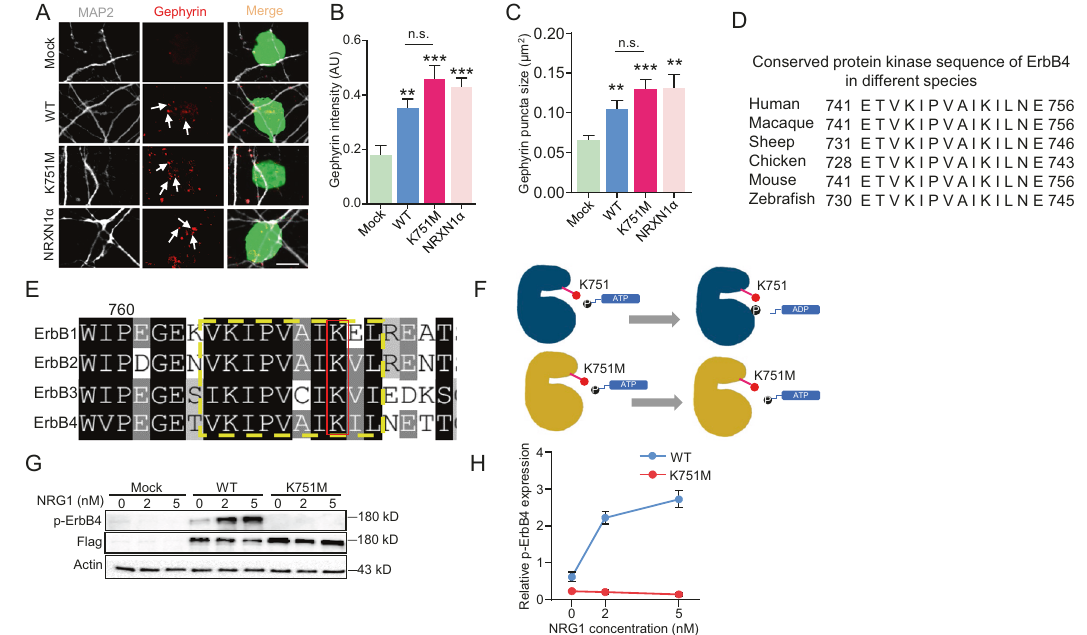
Fig. 1 ErbB4 induces inhibitory postsynaptic gephyrin puncta. A – C ErbB4-transfected HEK293T cells could induce gephyrin puncta. HEK293T cells expressing ErbB4-WT, K751M, NRXN1 α , or empty vector (Mock) were co-cultured with hippocampal neurons (DIV9~10) and stained for MAP2 and gephyrin. Arrows indicate GABA A R α 1 puncta contacting with dendrites. Scale bar, 10 μ m ( A ). Quantitative analysis of the intensity ( B ) and size ( C ) of gephyrin puncta in A . n = 20 cells for Mock, n = 21 cells for WT, n = 29 cells for K751M, and n = 29 cells for NRXN1 α . Data were shown as mean ± SEM; ** p < 0.01, *** p < 0.001, n.s. p > 0.05. Student ’ s t test. D – E The kinase domain of ErbB4 in different species ( D ) and K751 in ErbB family ( E ) are highly conserved. F Schematic illustration for kinase-dead of K751M mutant. G – H The kinase activity of K751M was completely lost. HEK293T cells were transfected with Flag-tagged ErbB4-WT, K751M, or empty vector (Mock) and treated with different concentrations of NRG1 for 15 min. The cells were lysed and probed with indicated antibodies ( G ). The relative intensities of phosphorylated ErbB4 (p-ErbB4, Y1284) to Flag-ErbB4 from three independent experiments were quanti fi ed ( H ). Data were shown as mean ± (Fig. 2B). Unlike Null mice that die at E11 because of defective heart development [44], K751M homozygous mice were viable at birth and fertile, without apparent change in life expectancy (Fig. S2A-2B). To determine whether K751M is true “ kinase-dead ” , brain slices were prepared from WT or K751M homozygous mice, and treated with NRG1 at different concentrations in ACSF for 15 min and lysed (Fig. 2C). The lysates were subjected to IP with anti- ErbB4 antibody and probed for p-ErbB4. As shown in Fig. 2D, E, p- ErbB4 was increased with increasing concentrations of NRG1 in WT mice, while p-ErbB4 was not detected in the complex precipitated with IgG, indicating the speci fi city of anti-p-ErbB4 antibody. Remarkably, p-ErbB4 was not detectable in slices from K751M homozygous mice (Fig. 2D, E). These results suggest that K751M could not be activated in vivo. NRG1 is known to increase the frequency of miniature inhibitory postsynaptic currents (mIPSCs) in the hippocampus in a manner dependent on ErbB4 kinase activity [23, 37, 45]. Next, we determined whether K751M alters mIPSCs. Hippocampal CA1 PyNs were recorded in the presence of tetrodotoxin (TTX) to block action potentials and CNQX plus DL-AP5 to block glutamatergic transmission (Fig. 2F). As shown in Fig. 2G – I, NRG1 treatment (5nM, 15min) increased the mIPSCs frequency, but not amplitude in WT slices, in agreement with earlier reports [23]. However, this effect was occluded in K751M mice (Fig. 2H). These data support NRG1 ’ s ability to increase mIPSCs frequency is impaired in K751M mice, alluding to a model where ErbB4 kinase activity is needed for inhibitory transmission. Normal gross anatomy and number of INs in K751M mouse brain Although NRG1 was unable to increase mIPSCs frequency in K751M slices, baseline levels of both mIPSCs frequency and